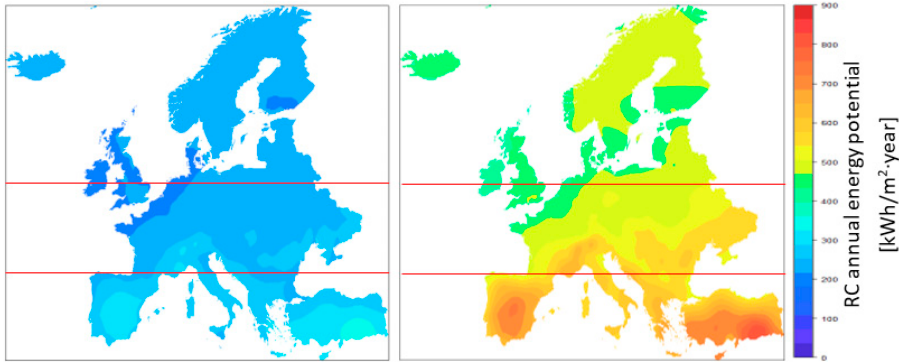
Figure 3. Map of annual energy potential (kWh/m 2 · year) of nighttime RC ( left ) and all-day RC of an ideal solar reflective surface ( right ). Horizontal red lines divide the map into three zones: north